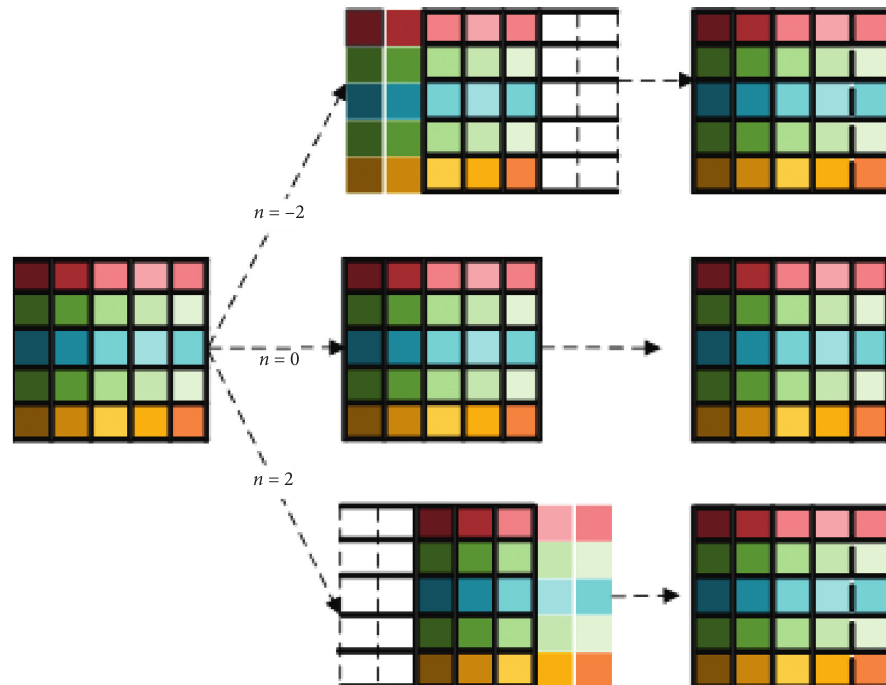
Figure 4: Schematic diagram of phase disturbance operation of feature map.